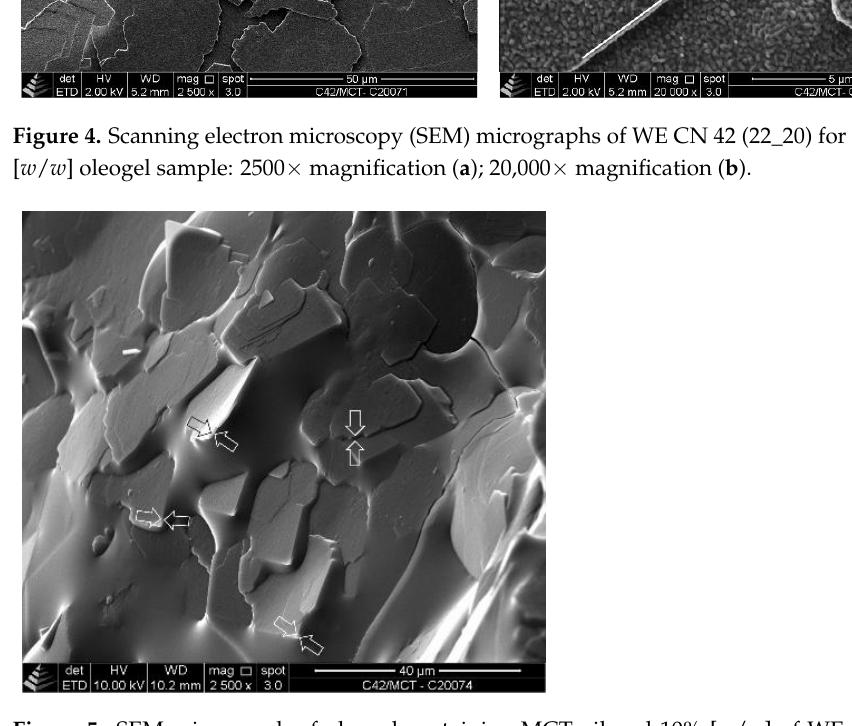
Figure 5. SEM micrograph of oleogel containing MCT oil and 10% [ w / w ] of WE CN 42 (22_20) (2500× magnification). Arrows: measuring positions for the determination of the crystal thickness.